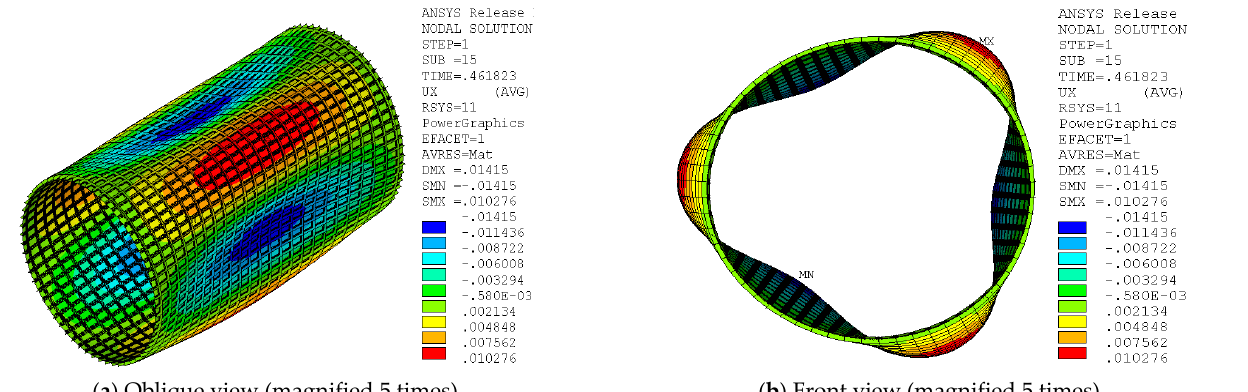
Figure 13. Radial displacement contour map at the upper critical point of the post-buckling path for the model of the T-type stiffened cylinders with the SS3 boundary when the material is brass and ξ = 0.05.